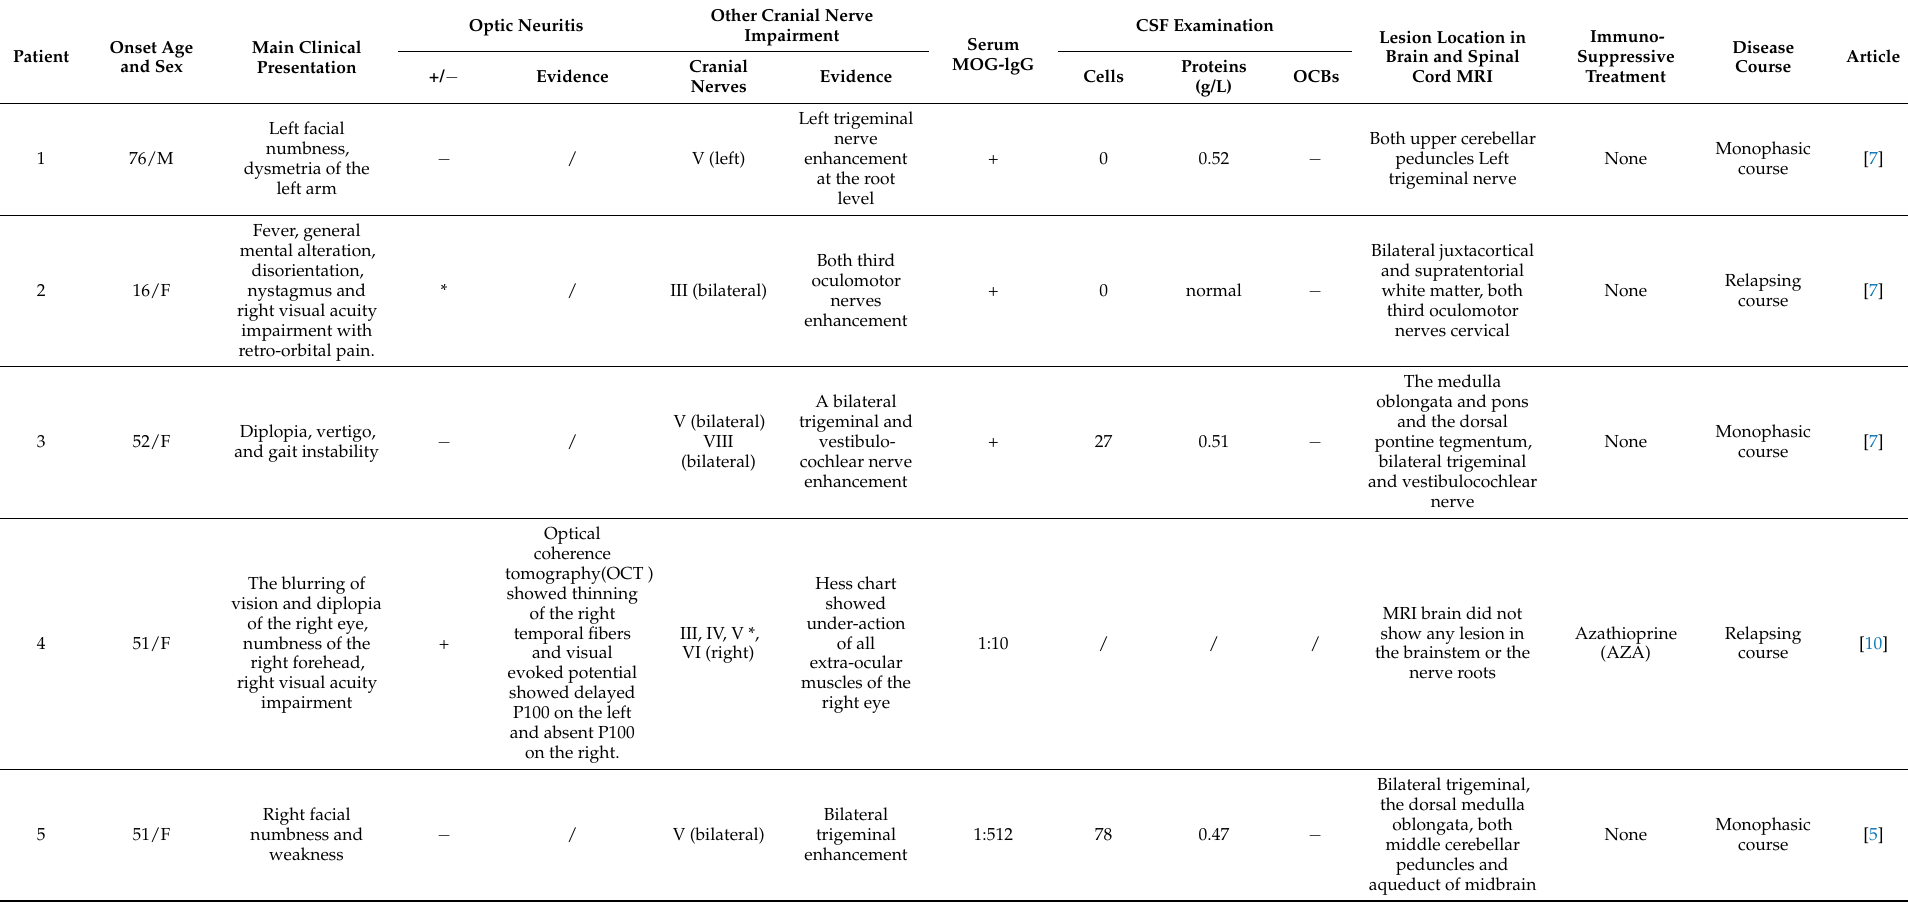
Table 1. Summary of the case reports that targeted MOG-associated cranial